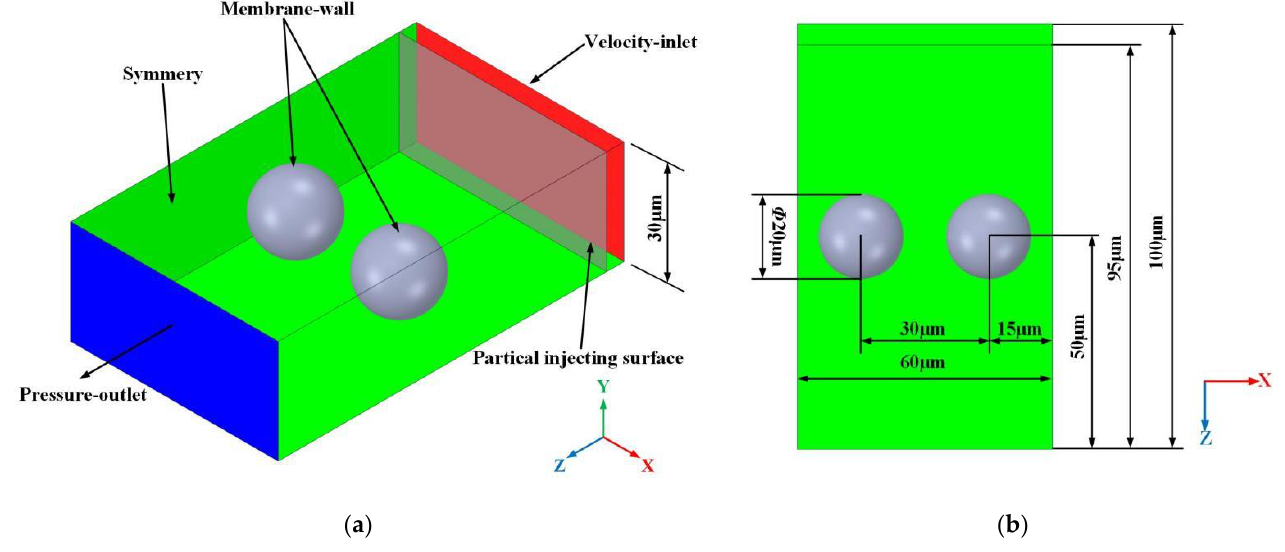
Figure 2. The structure of the pores of the ceramic membrane and the size of the computational domain. ( a ) Isometric view; ( b ) XZ plan